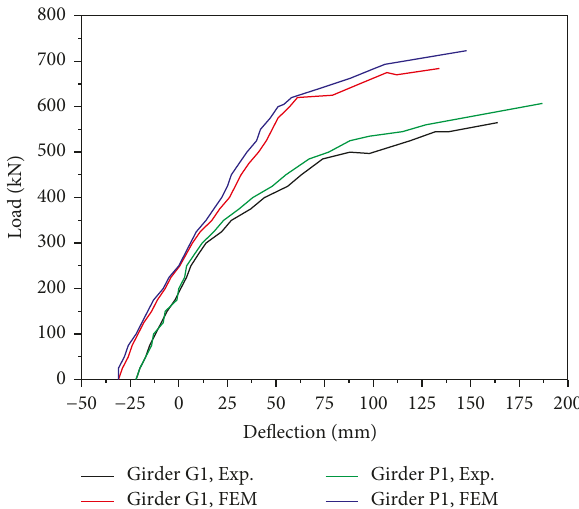
Figure 21: Comparison of FEM and experimental load–net de- flection curves for girders G1 and P1.